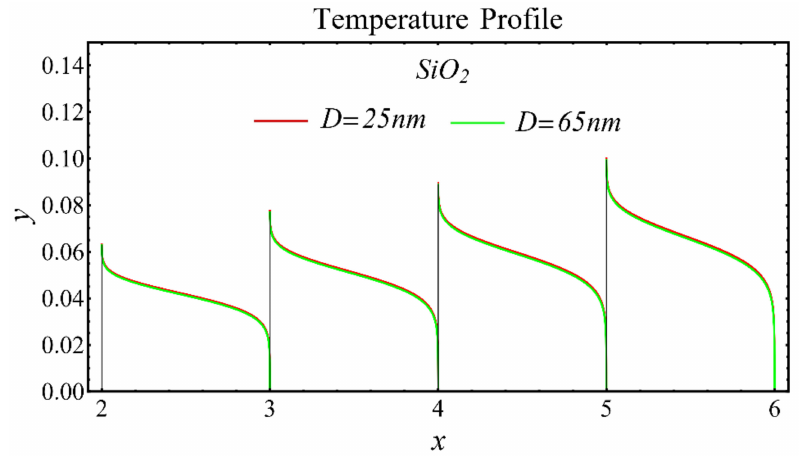
Figure 16. Temperature profile of SiO 2 -EG nanofluid under influence of nanoparticle diameter.